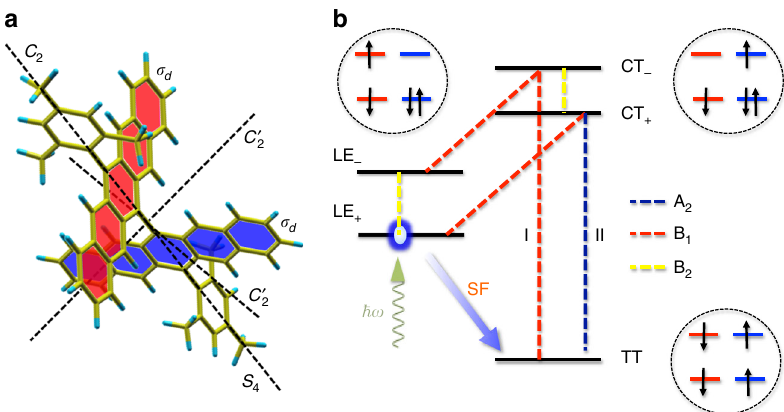
Fig. 1 Molecular structure and electronic modelling of singlet fi ssion in 13,13 ′ -bis(mesityl)-6,6 ′ -dipentacenyl. a 13,13 ′ -bis(mesityl)-6,6 ′ -dipentacenyl (DP- Mes) showing symmetry elements at the ground state geometry computed by DFT (point group D 2 d ). Pentacene monomers also indicated (red, blue). b Illustration of the ab initio electronic model showing energy-level ordering (not to scale) and typical electronic con fi gurations de fi ning the locally excited (LE), charge transfer (CT) and doubly excited triplet-pair (TT) states. Dashed lines indicate interstate vibronic couplings labelled by normal mode symmetries. The initial photoexcited state (LE + ) is not coupled to TT; it must decay via vibronic superexchange mediated by CT states. This is a second- order process, so can involve two interactions with the same environment (path I, coherent) or different environments (path 2, incoherent). A 1 ‘ tuning ’ modes (not shown) shift the energy levels of each state but do not induce any interstate